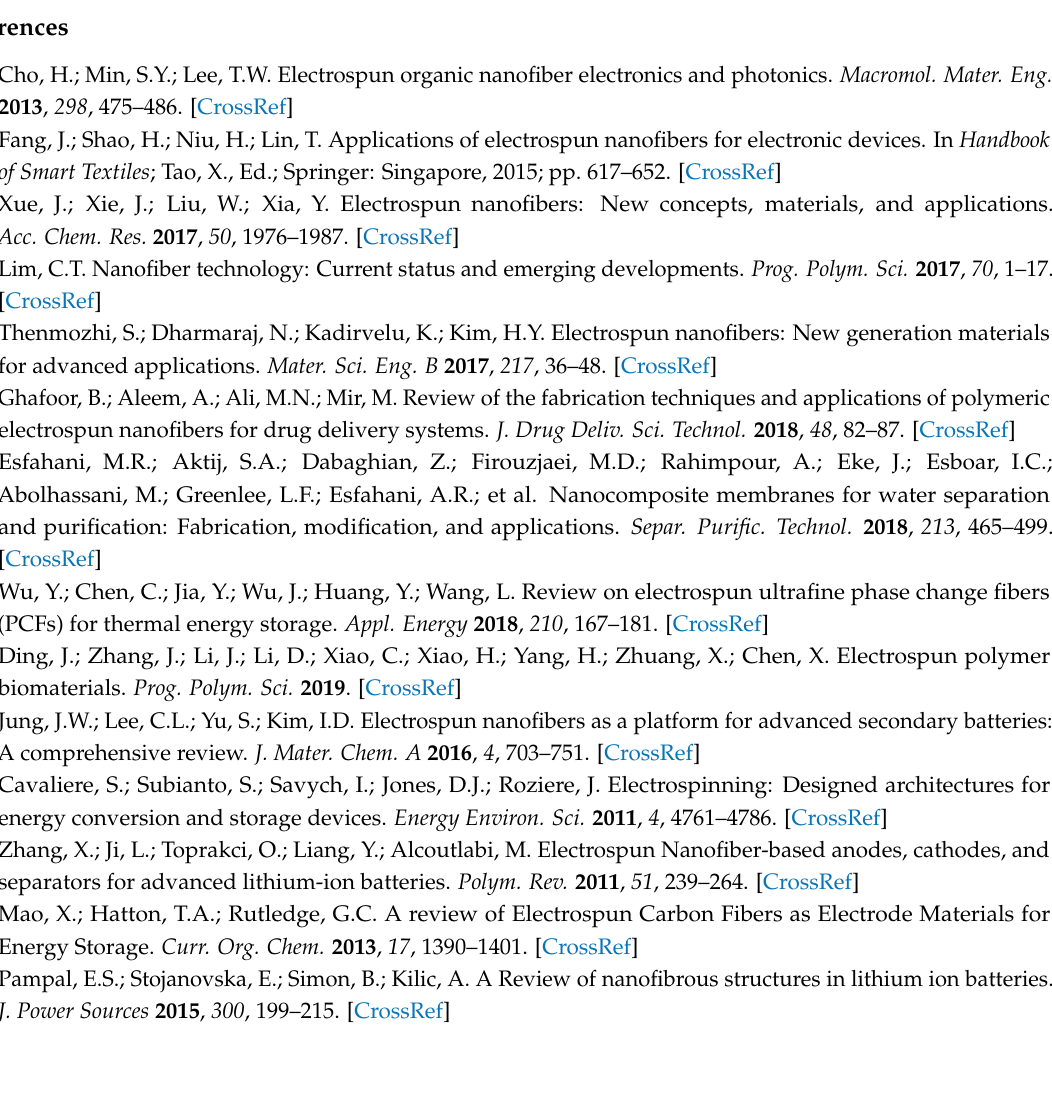
Table S1: ENMs for SIB cathodes and preparation conditions; Table S2: Main parameters describing the performance of cathode ENMs in SIBs; Table S3: ENMs for SIB anodes and preparation conditions; Table S4: Main parameters describing the performance of cathode ENMs in SIBs; Table S5: Electrode ENMs for supercapacitors and preparation conditions; Table S6: Main parameters describing the performance of electrode ENMs in supercapacitors; Table S7: Electrospun photo-catalysts for WS and preparation conditions. Funding: From the Italian Ministry of Education, University and Research (MIUR) through the project “Towards sustainable, high-performing, all-solid-state sodium-ion” (PRIN 2017MCEEY4) and from MDPI for the publication in open